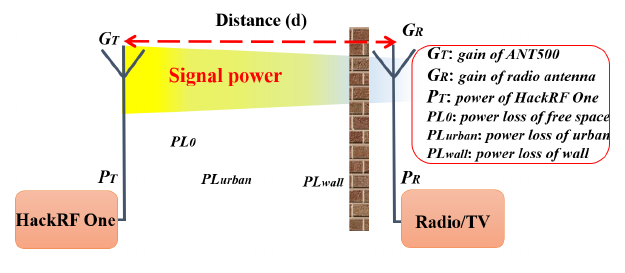
Figure 2. Power gain and loss through the transmission